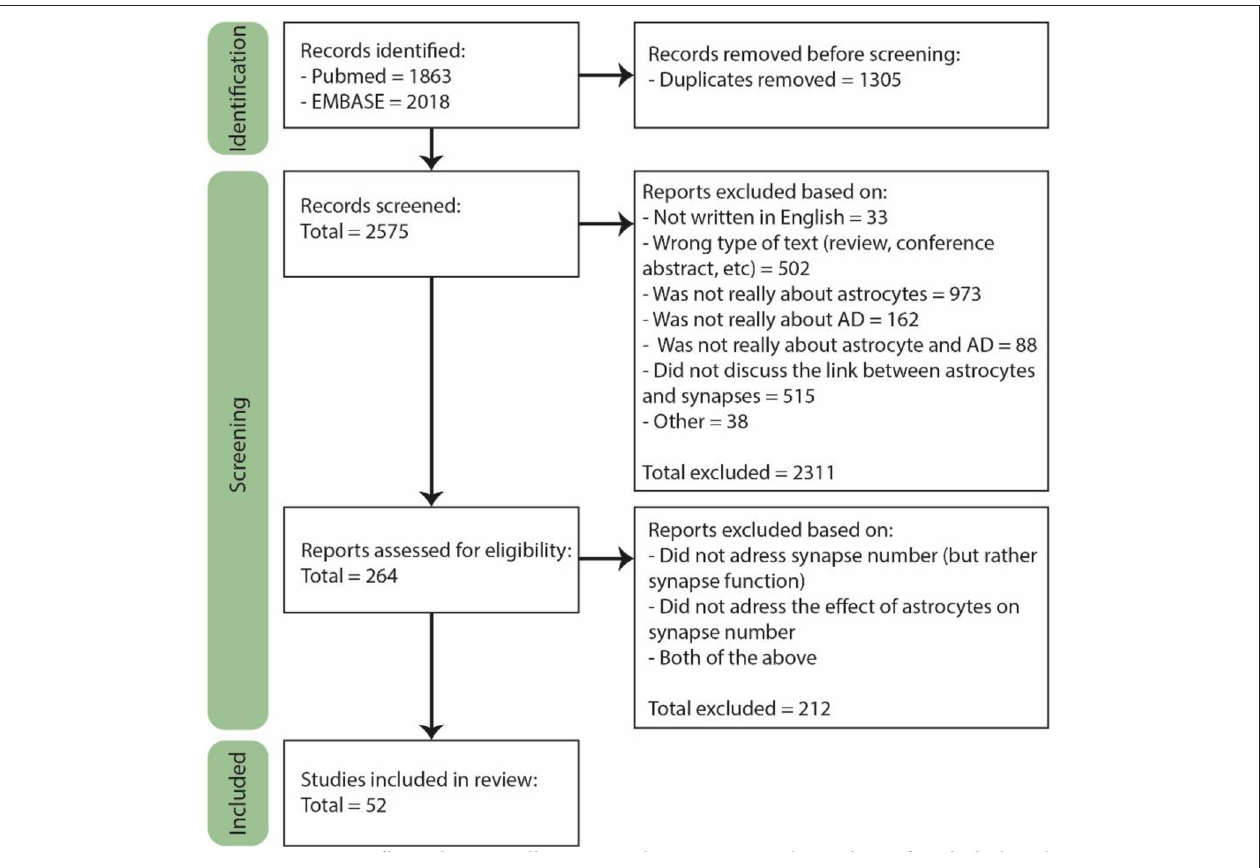
FIGURE 1 | PRISM flow diagram illustrating the process and number of included and rejected papers throughout selection. During each step of the selection process papers were excluded based on several exclusion criteria. Figure adjusted from Page et al.